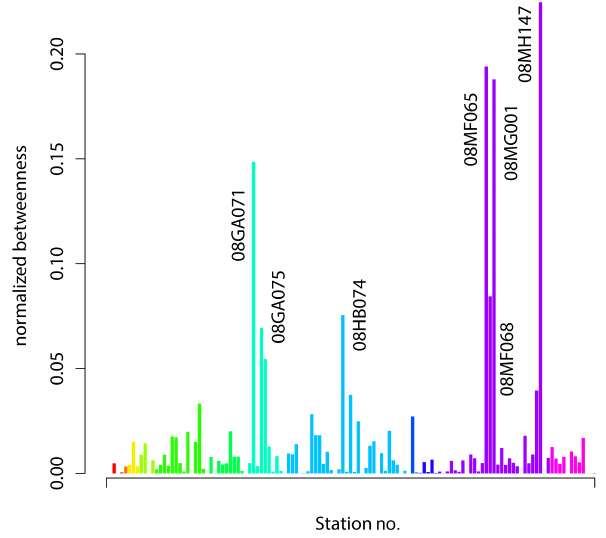
Figure 12. Bar plot of the betweenness scores for every station, with several high-betweenness stations highlighted. The station colours are based on the WSC designated subregion shown in Fig.